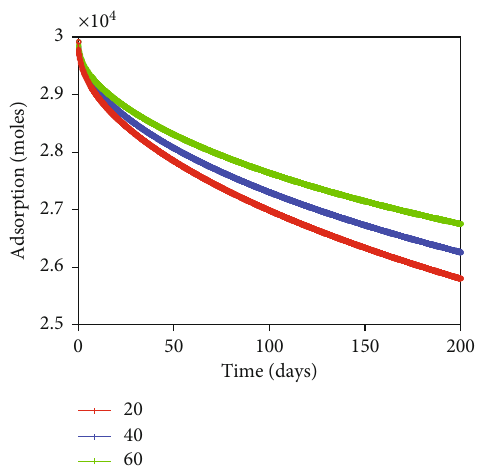
Figure 20: Total adsorption curves under di ff erent values of c